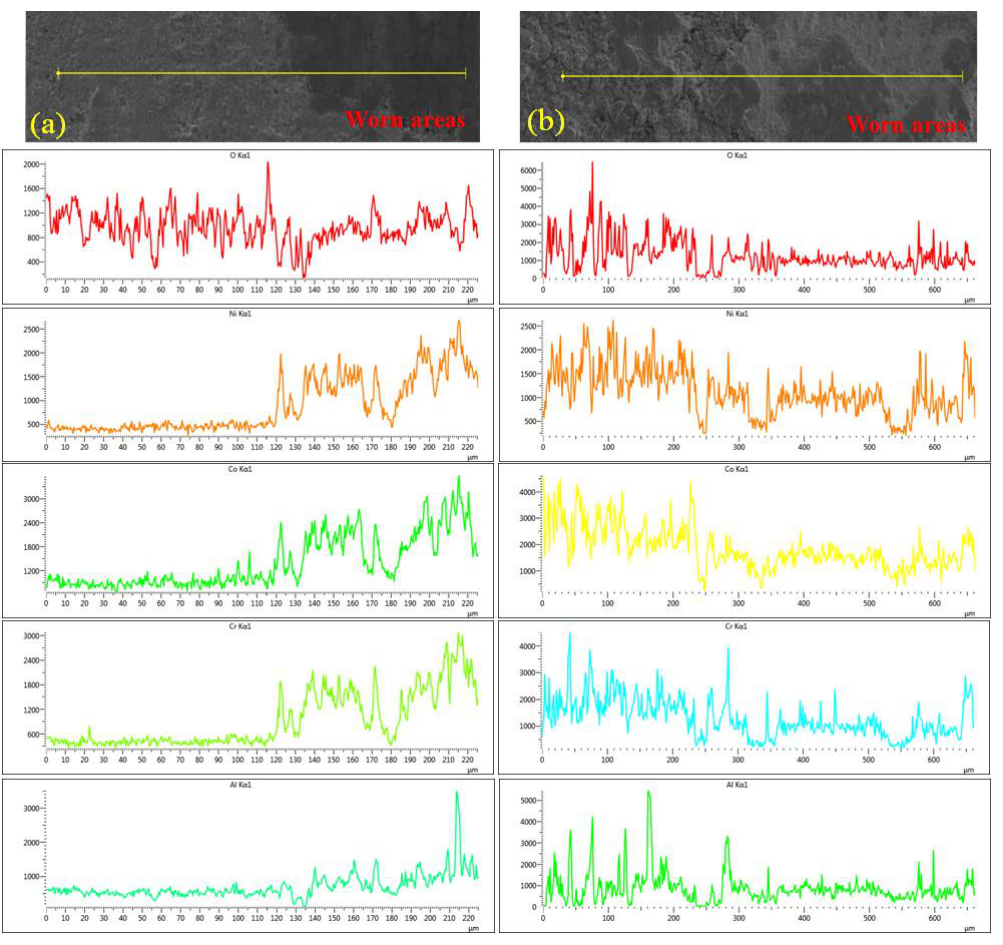
Figure 7. EDS linear analysis of wear tracks at 500 °C under 2 N load: ( a ) D-gun coating technique; ( b ) SSPS coating technique.